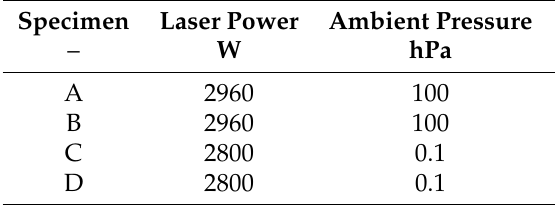
Table 1. Welding parameters of the selected test specimens.